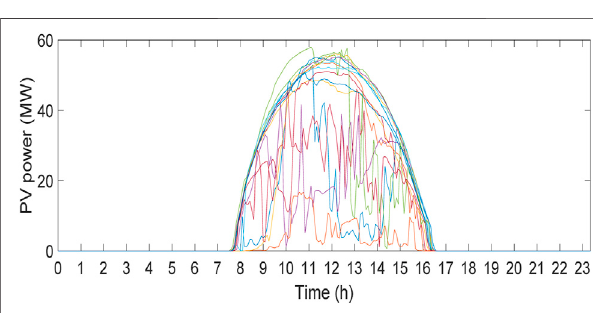
FIGURE 2 | Realistic generation pro fi les for 25 PV systems in 24